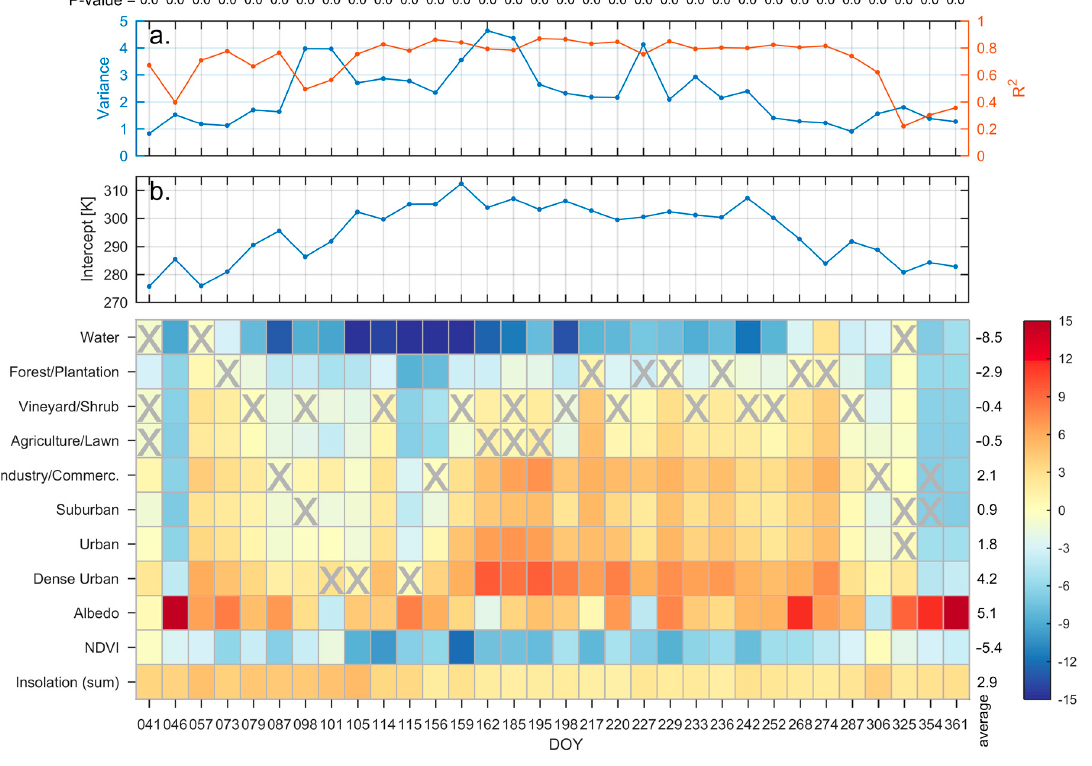
Figure 7. The 2D surface plot shows the resulting coefficients of each predictor (y-axis) for every scene (x-axis, ordered after DOY) in the multiple regression model with reddish colors indicating an increase to the intercept, which is shown in ( b ), and blueish colors indicating a decrease to the intercept. The column at the right end of the surface plot lists the total average of each coefficient, ( a ) shows the respective variance (left axis, blue) and R 2 values (right axis, orange) for each regression run and the numbers above indicate the respective p -value for each run. All predictors are normalized from zero to unity and flagged with a gray cross in case of low individual significance.